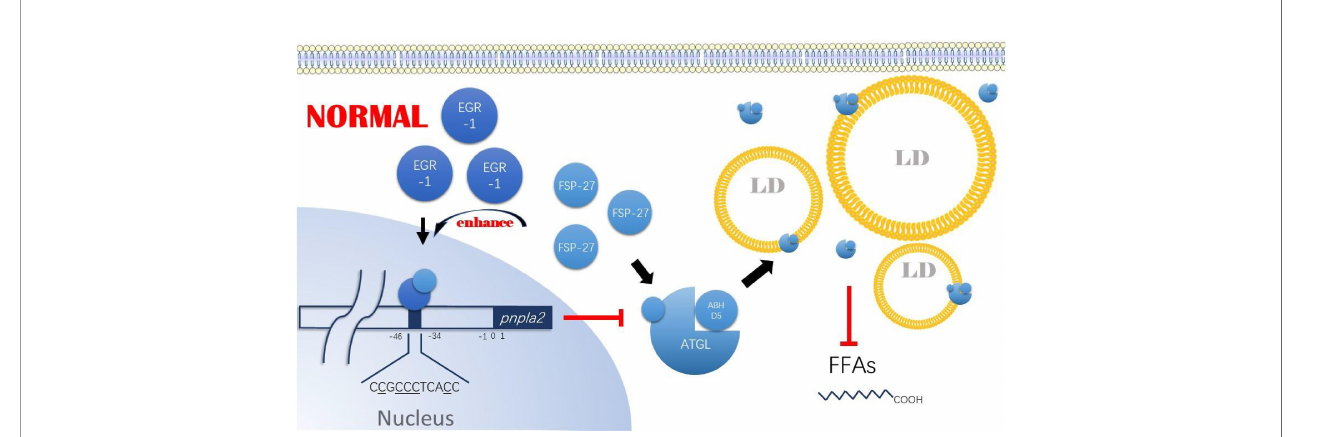
FIGURE 4 | FSP-27/EG R-1 /ATG L axis. Under nom1al conditions, FSP-27 can bind to the core structural doma in of ATGL, aa 120-220, and inhibit its triglyceride hydrolysis function. Tn addition, FSP-27 can promote the bin di ng ofEGR-1 to the -45/-34 region upstream of pnpla2, thereby inhibiting ATGL expression. Ultimately, the intracellular ATGL content decreases, and its activity is reduced, allowing intracellular lipid droplet accumulation. FSP-27, Fat-speci fi c protein 27; EG R-1, Early growth response protein I; ATGL, Adipose triglyceride lipase; A-BH DS, 1 – acylglycerol-3- phosphate 0-acyltransferase; LDs Lipids droplet; F'FAs, Free fatty